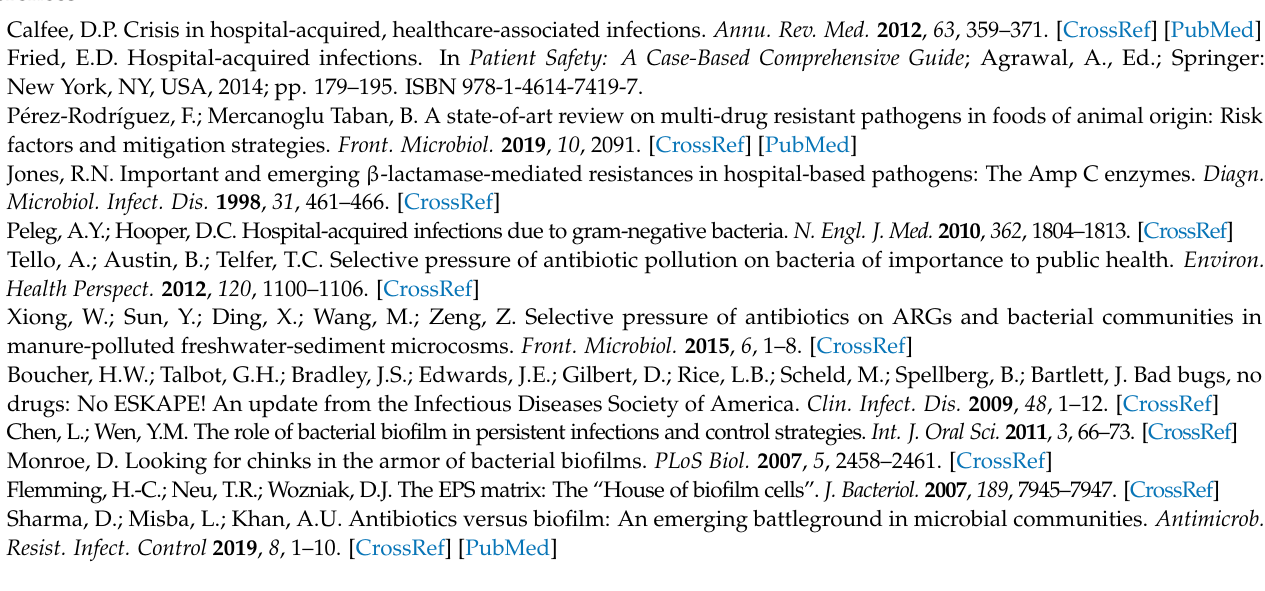
control. Figure S4: Effect of DIM on bioluminescence induction. Figure S5: Qualitative assays of P. aeruginosa PAO1 and A. baumannii swarming motility. Table S1: Primer sequences. Table S2: Minimal inhibitory concentrations (MICs) of six antibiotics in µ g/ml against P. aeruginosa PAOmucA22 Ref [93] is mentioned in the Supplementary